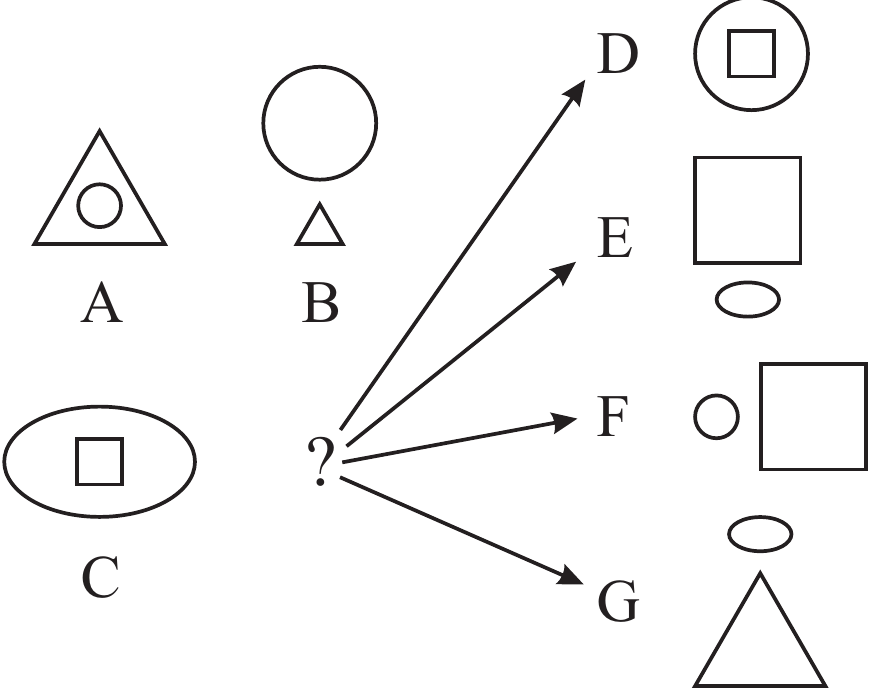
Figure 29. A geometric analogy